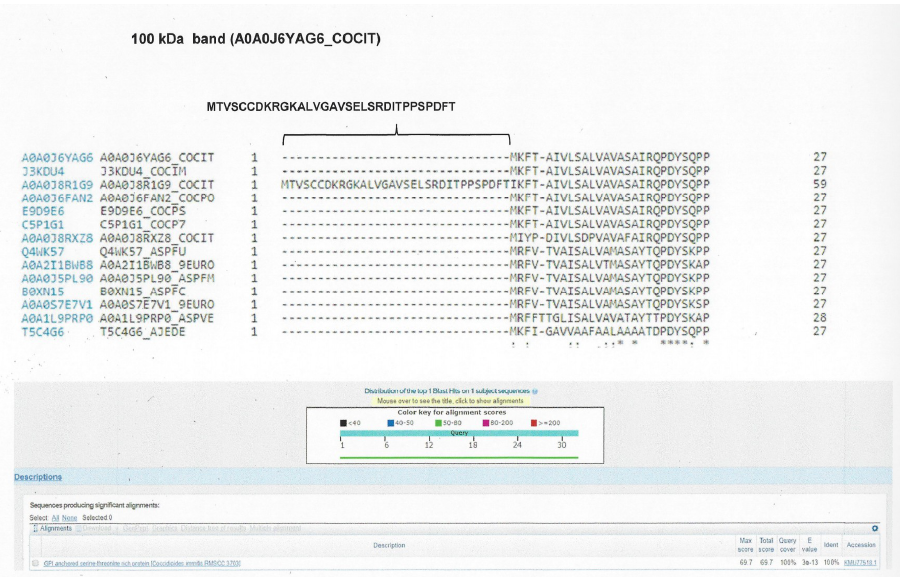
Figure 3. Alignment map with the BLAST protein program. The selected peptide of the assembled protein corresponding to the 100 kDa band is shown, identified through aligned sequences of Coccidioides spp. and related fungi. The selected peptide was compared through the BLAST program to confirm its specificity.